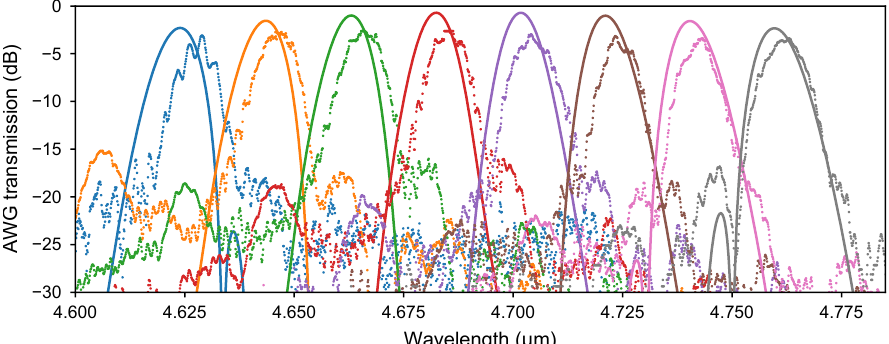
Figure 9. Transmission spectra for a similar AWG, fabricated separately from the QCL array. The solid curves are simulated and the points are measured data.